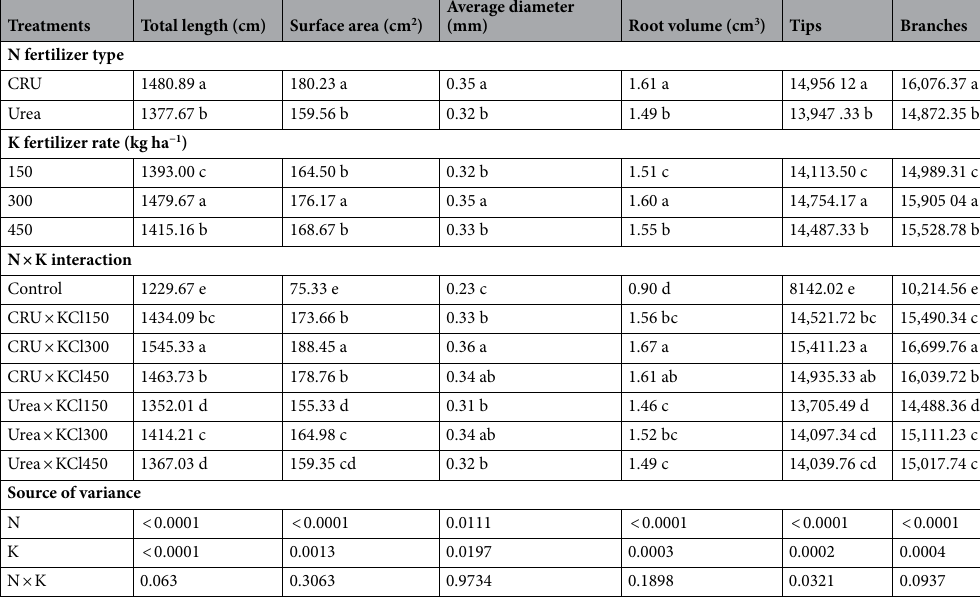
Table 5. The root morphology of Italian ryegrass at the fourth clipping stage. Means followed by different lowercase letters in the same column were significantly different based on analyses with ANOVAs followed by Duncan tests ( P < 0.05). Control no N and K fertilizer, CRU controlled-release urea, KCl potassium chloride.